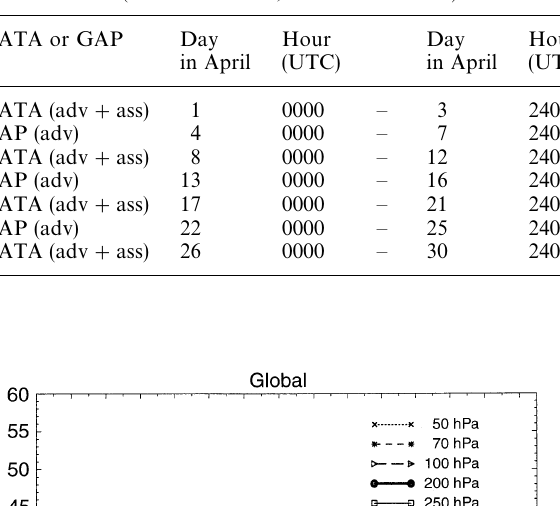
Table 1. Description of data used to test which wind-field level is the optimal choice to run the AMK. As a test case, TOVS data of April 1992 are taken (adv " advection, ass " assimilation)